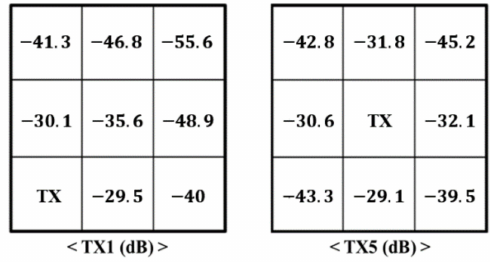
Figure 7. Crosstalk voltage level on TX1 and